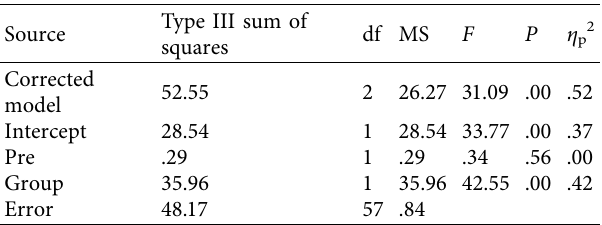
Table 7: Analysis of covariance (ANCOVA) comparing posttest scores across